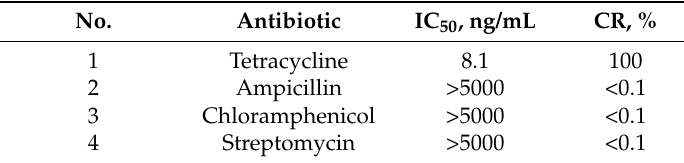
Table 2. Parameters of specificity in the developed immunochromatographic assay.